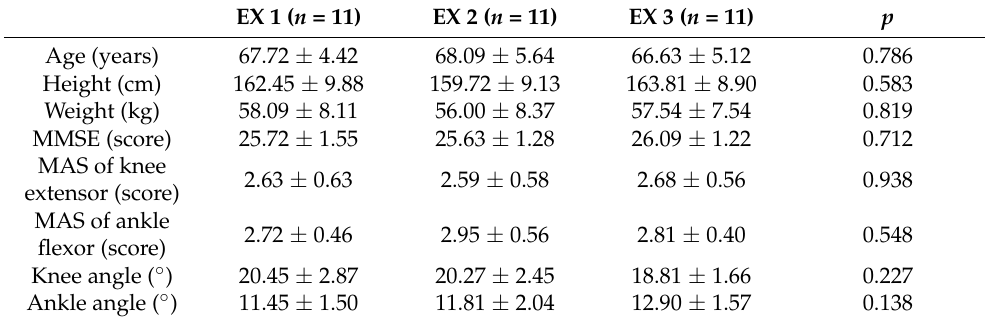
Table 1. General characteristics of subjects and homogeneity test of pre-test